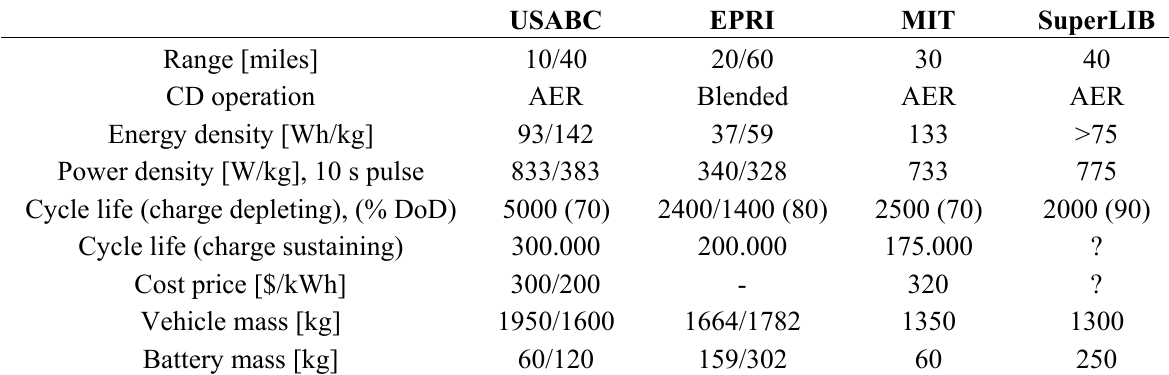
Table 7. Plug-in Hybrid Electric Vehicle requirements [6,57–59].